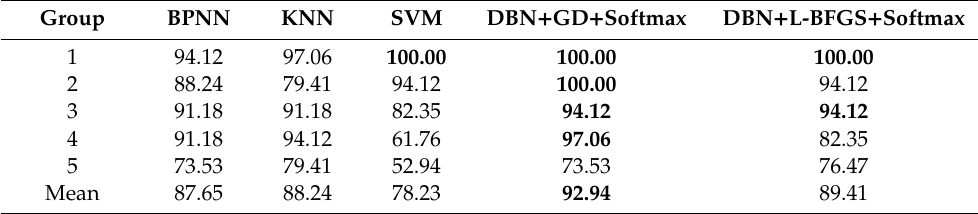
Table 2. Accuracies of the classification of negative spectrum data in the five-fold cross-validation experiment (%).